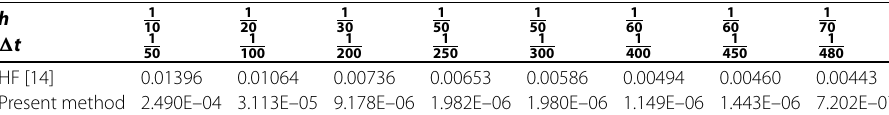
Table 3 Error norms and order of convergence for Example 1 , γ = 1.5 for different N when (cid:2) t = 1 120 N